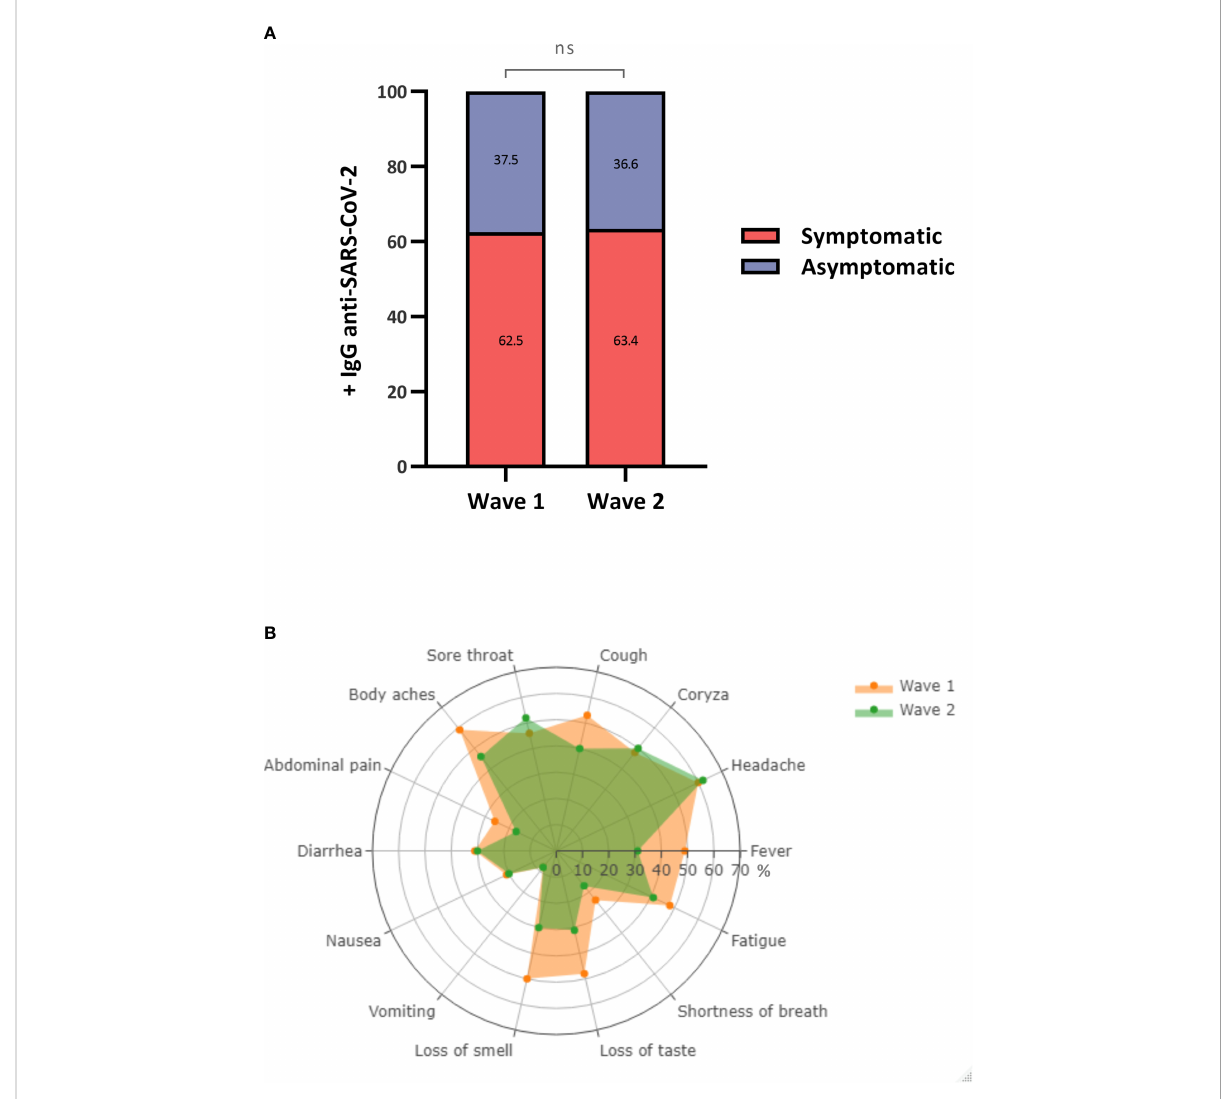
FIGURE 4 Prevalence and frequency of antibodies and symptoms among symptomatic and asymptomatic individuals. (A) Percentage of +/- anti-SARS-CoV-2 IgG antibodies between symptomatic and asymptomatic individuals. (B) Frequency of symptoms characteristic of COVID-19. ns, not signi fi